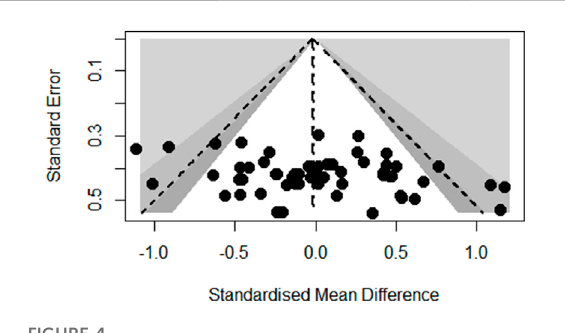
FIGURE 4 Funnel plot of glycometabolism and lipometabolism outcomes.